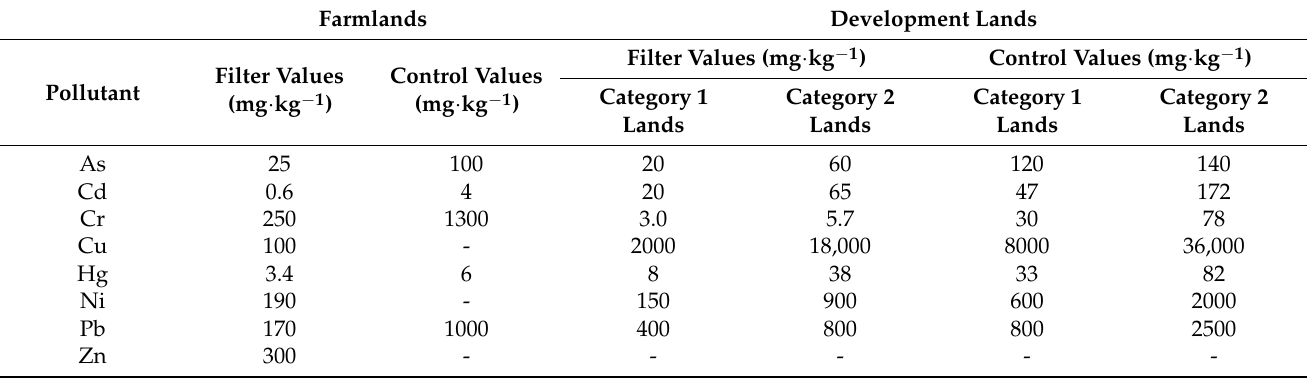
Table 6. Filter and control values of the heavy metal pollution risk for farmlands (pH > 7.5) and development lands (mg · kg − 1